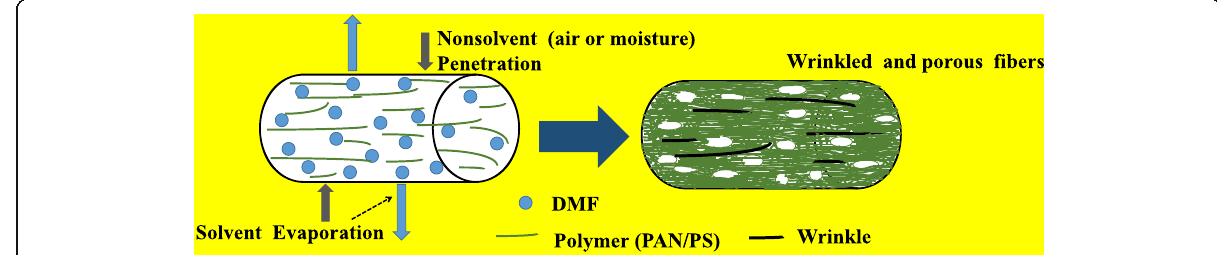
Fig. 2 Schematic diagrams illustrating the formation process of wrinkled and porous fiber in